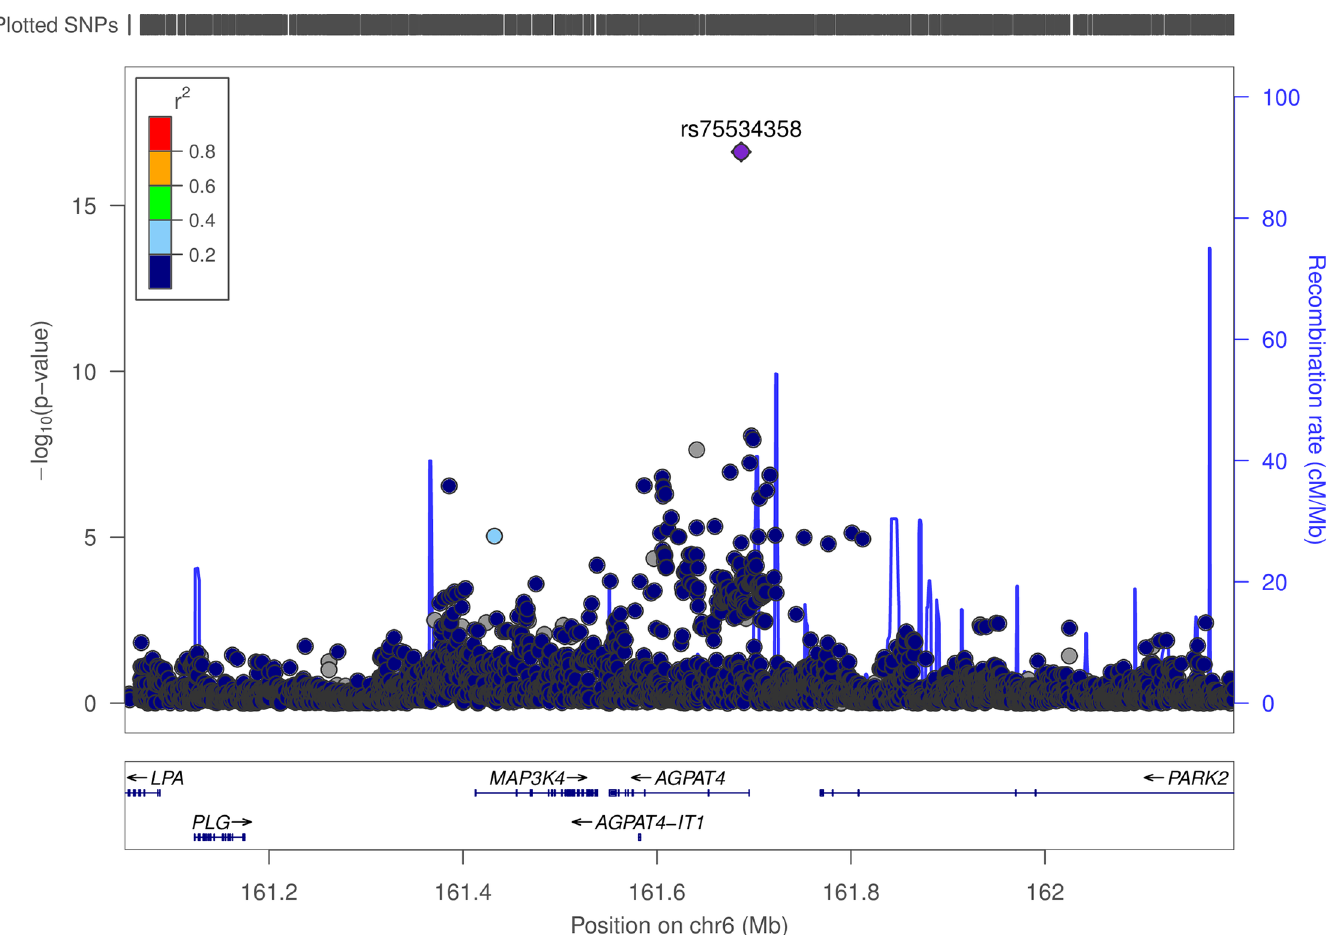
Fig 2. LD structure for variants associated with ELONG2_N6 in and near AGPAT4